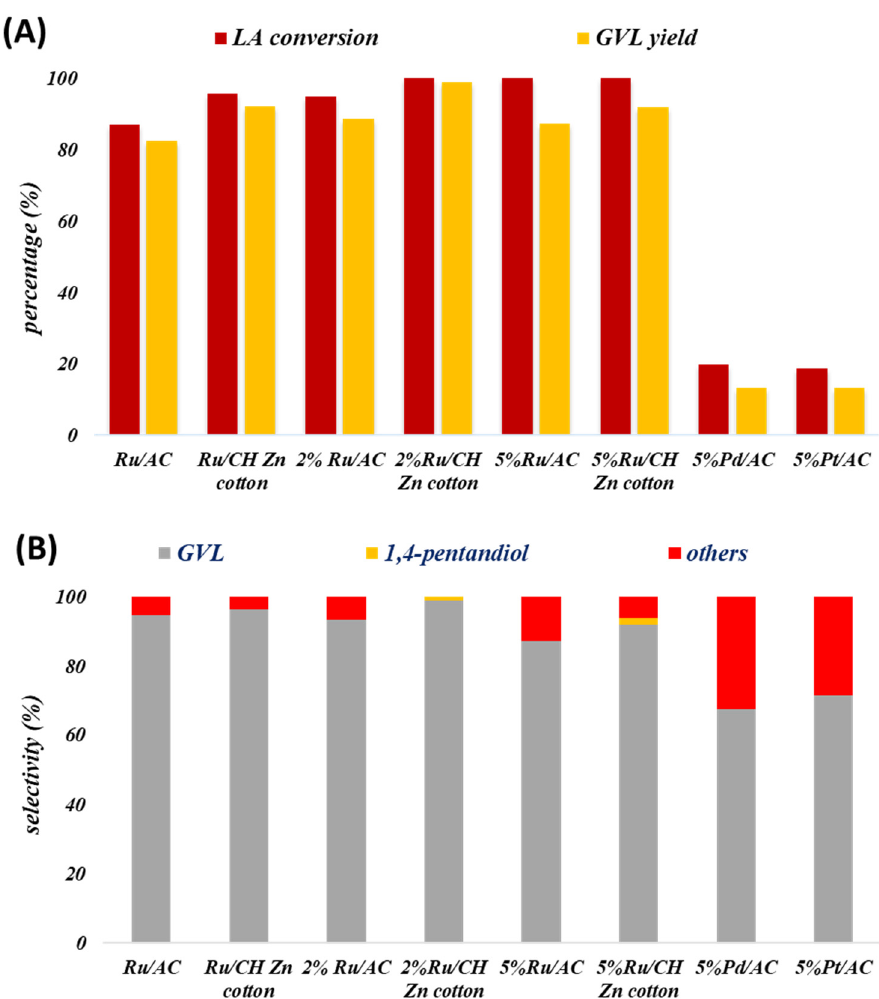
Figure 2. Catalyst screening: ( A ) LA conversion and GVL yield, ( B ) product selectivity. Reaction conditions: 120 min, 100 °C, 10 mL of H 2 O, (LA) 0.5 M, 10 mg of catalyst, 10 bars P H2 .